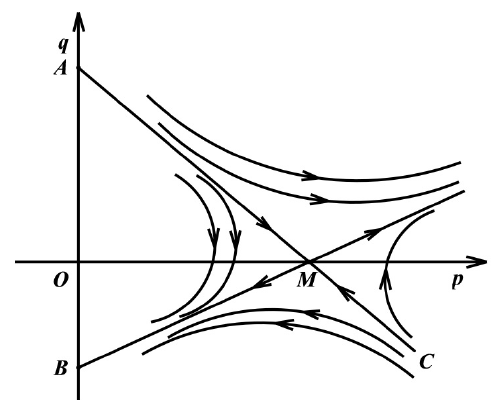
Fig. 2 The differential equation model to stabilise